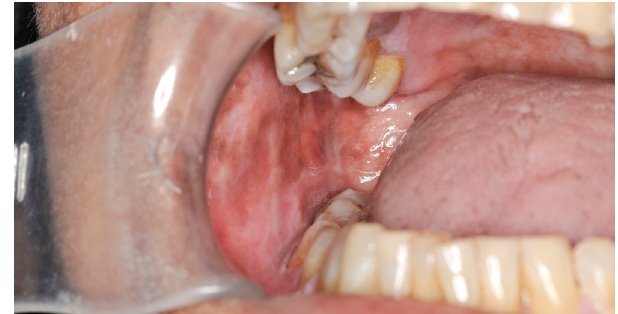
Fig. 8. Oral submucous fi brosis: Whitening with areas of mild background erythema and pigmentation involving the right buccal mucosa (image provided by Guy ’ s and St Thomas ’ ).